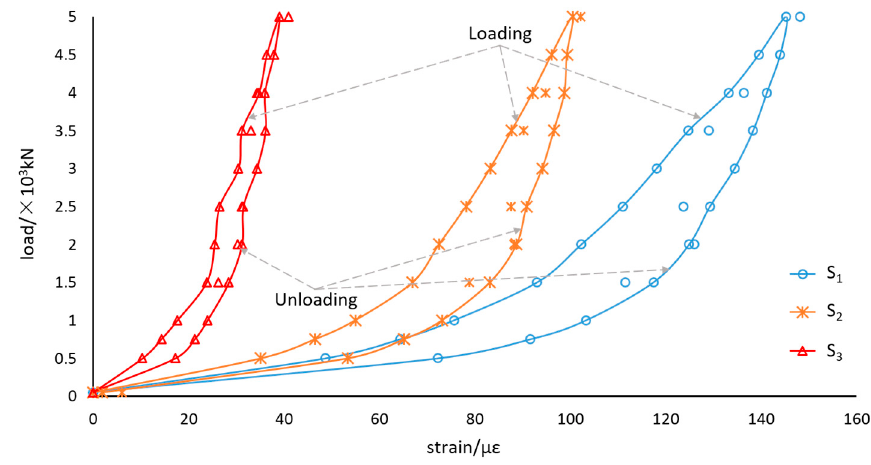
Figure 8. Fiber-optic sensors response of the bearing under the loading and unloading.